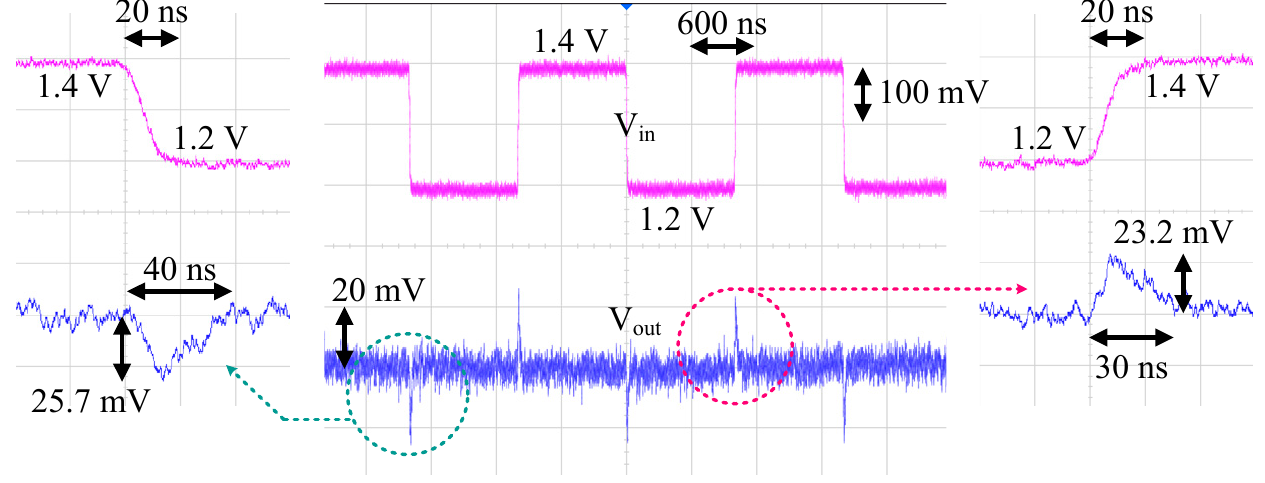
Figure 14. Line transient measurement result. Table 3 summarizes the performance of the proposed FVF LDO with other state-of- Table 3. Performance comparison with state-of-the-art LDOs. the-art LDOs. The proposed FVF LDO occupied a 0.037 mm 2 active area. The LDO output